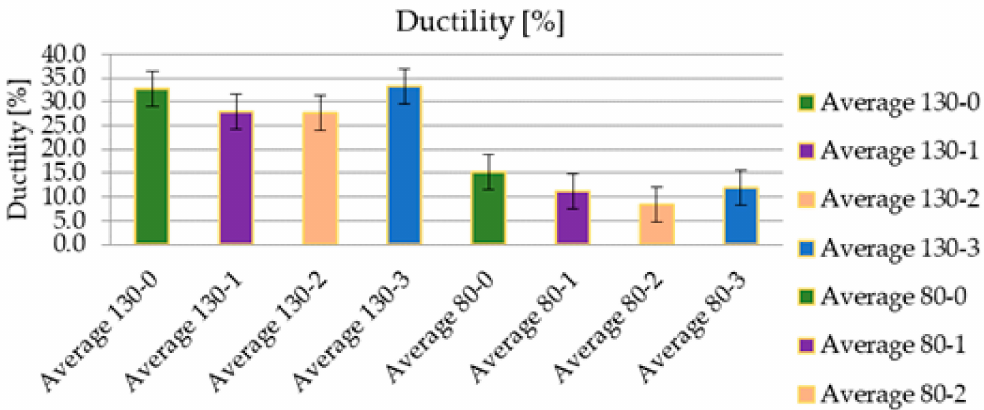
Figure 16. Comparison of average ductility [%] values between the type of RFID tag used and the type of fabric